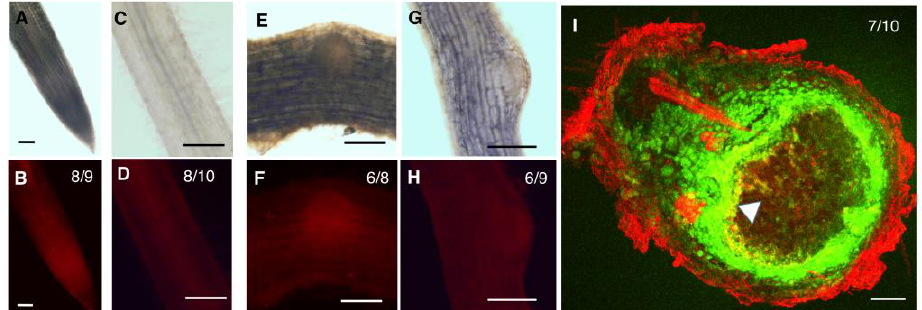
Figure 4. Spatio temporal expression patterns of GmHD-ZIPIII-2. Expression of GmHD-ZIP III-2p:TdTomato in whole mounts of a soybean root tip ( A , B ), mature root region showing the root stele ( C,D ), an emerging lateral root ( E , F ), and an emerging nodule ( G , H ), imaged using a compound fluorescence microscope. A , C , E and G are bright field images and B , D , F and H are corresponding fluorescence images obtained using a PI/TRITC filter. ( I ) A median section of a mature nodule longitudinal to the nodule axis showing expression of GmHD-ZIPIII-2p:TdTomato in the nodule parenchyma imaged using a laser confocal microscope. Tdtomato (red-false color) signal appears yellow due to overlap with a co-expressed constitutive GFP (green- false color) construct. Bright red fluorescence in the nodule and root peripheries and the root stele indicate non-specific fluorescence. See Figure S4 for split channels and color blind-friendly composite image. Scale bars are 100 µ m. The number of independent transgenic roots/nodules showing representative patterns out of the total number evaluated are indicated in panels B , D , F , H and I .